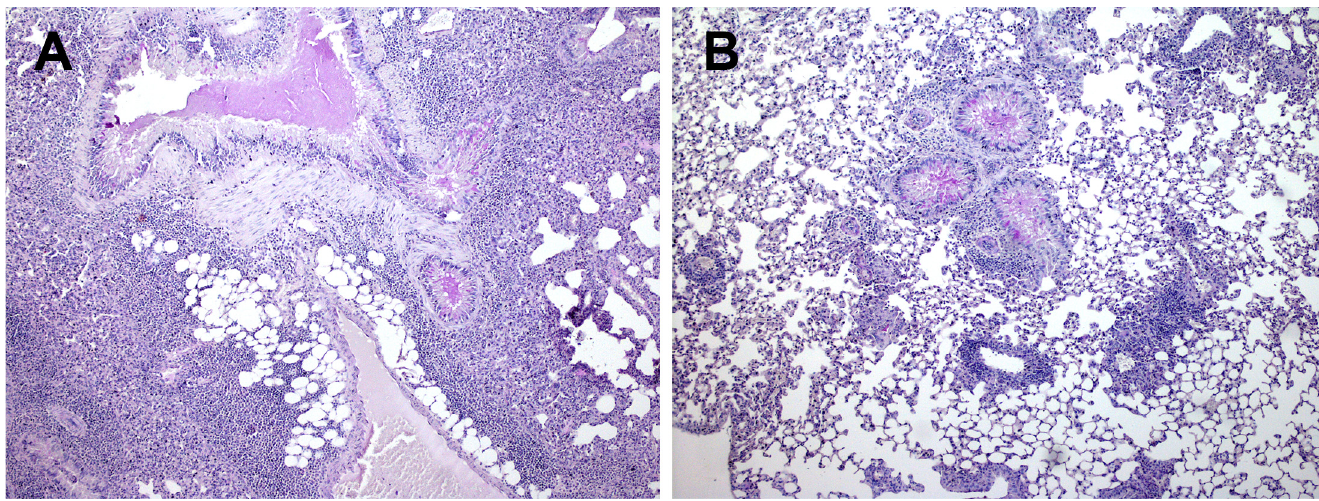
Fig 2. Increased inflammation in the lungs of NCR1 gfp/gfp mice H&E+PAS x180). NCR1 gfp/gfp C57Bl/6 mice were intraperitoneally (i.p) immunized with either OVA/alum or adjuvant only on days 0 and 14. Ten days after the second immunization mice were challenged twice intranasally with OVA at days 24 and 27. Twenty-four hours following the second immunization mice were euthanized and the left lungs were harvested for histology and RT-PCR. Representative Hematoxylin& Eosin (H&E) and PAS stained sections from each group are shown. Inflammation severity was assessed blindly by the pathologist. (A) OVA/alum immunized NCR gfp/gfp (H&E+PAS x180). (B) Alum immunized NCR gfp/gfp (H&E+PAS x180).